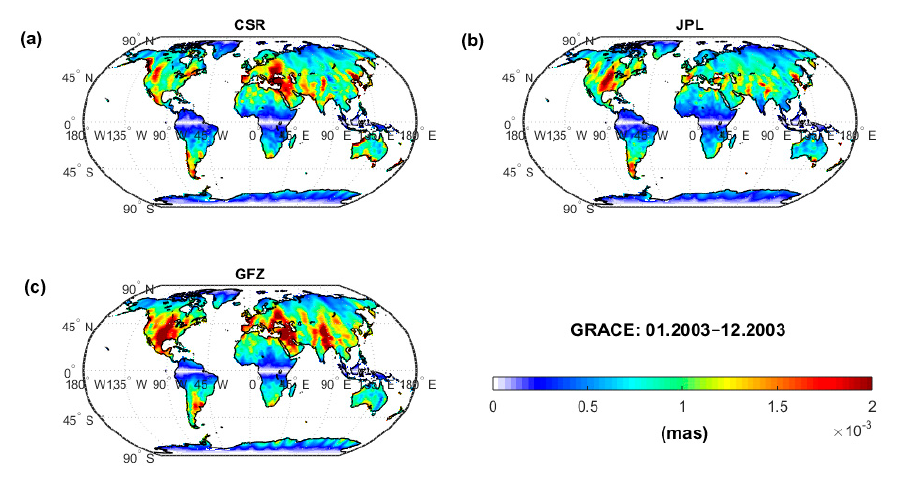
Figure 3. Maps of RMS of di ff erences between the mean GRACE solution (mean of data from CSR, JPL,